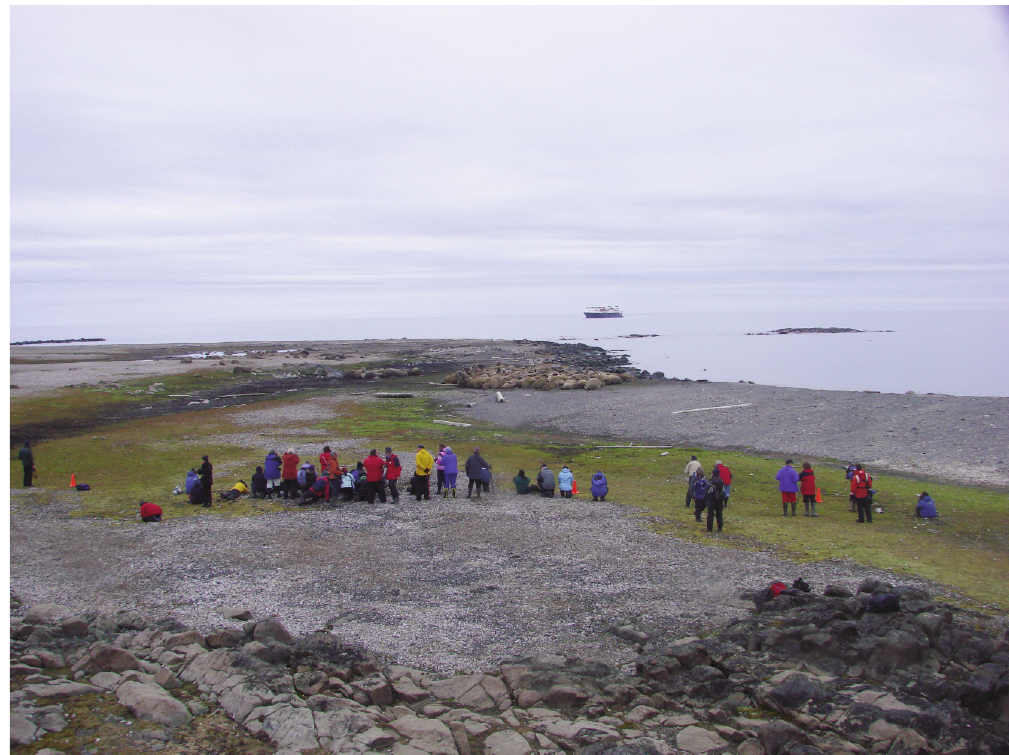
Fig 9. Picture taken by the surveillance camera at Lågøya showing the walrus haul-out, visit- ing tourists and the tourist ship in the